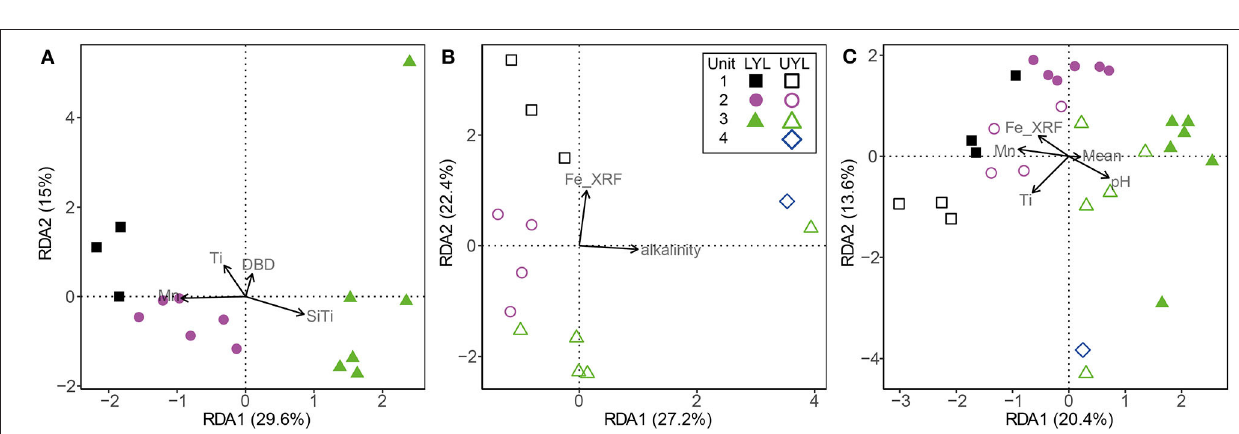
Frontiers in Microbiology |